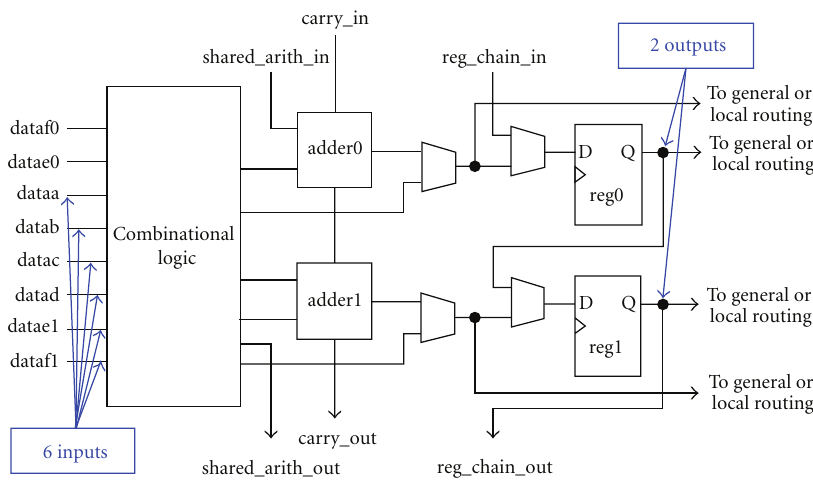
Figure 6: High-Level block diagram of an ALM, extracted from “Stratix II Device Family Data Sheet, volume 1” [24].